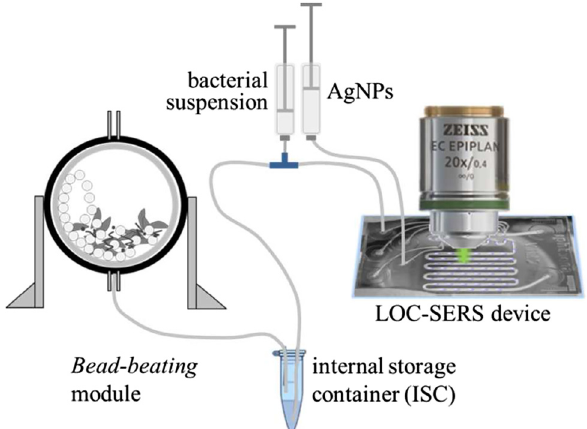
Figure 15: Scheme of sample preparation, including the sample lysing module (bead-beating system) for the bacterial cell disruption, the internal storage container, the syringe pump system and the droplet-based microfluidic device mounted to the micro- scope stage. Reprinted with permission from [75], Copyright (2016) American Chemical